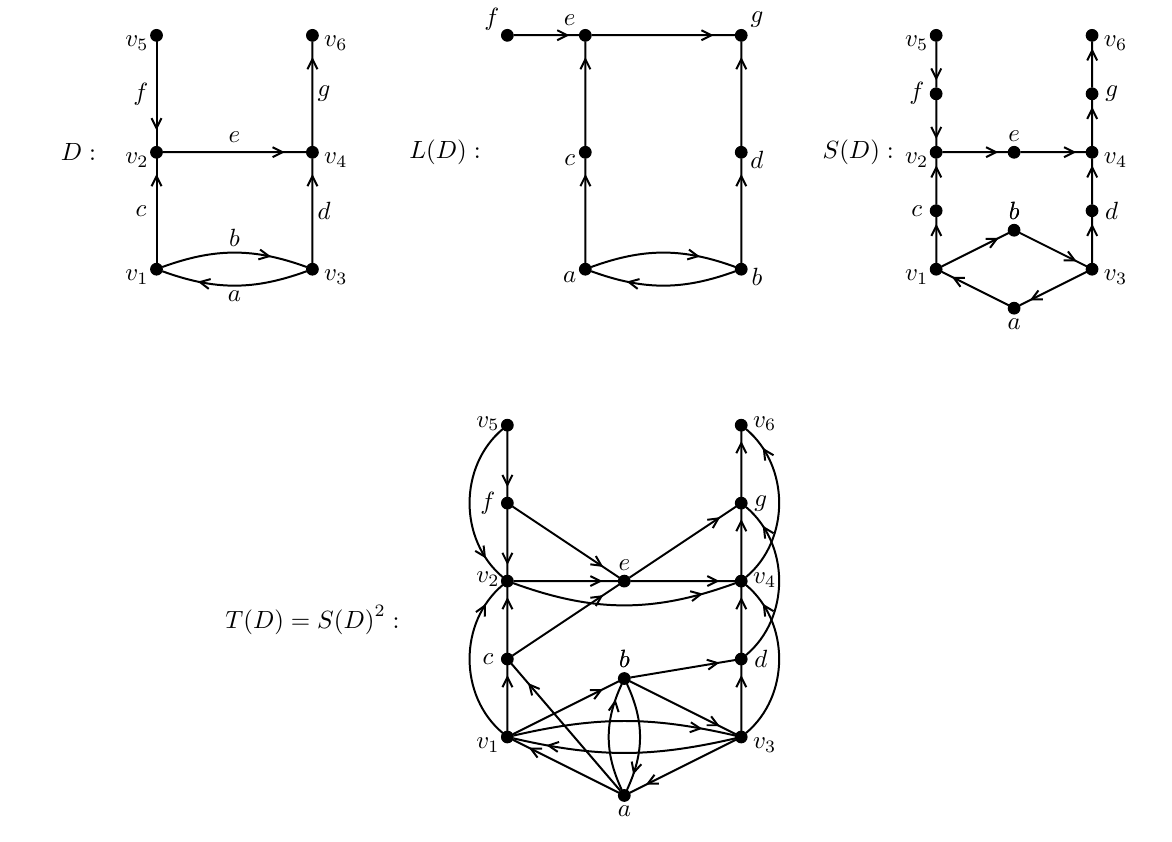
Figure 27: A digraph and its